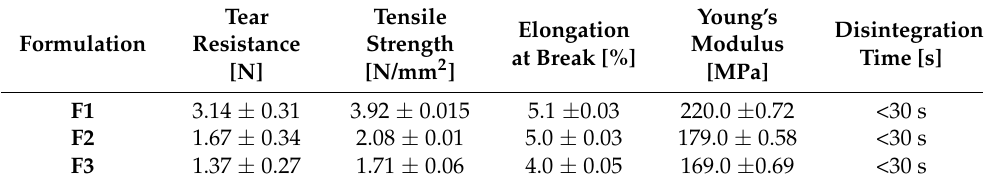
Table 1. Mechanical properties of obtained nanofibrous mats ( n = 3).